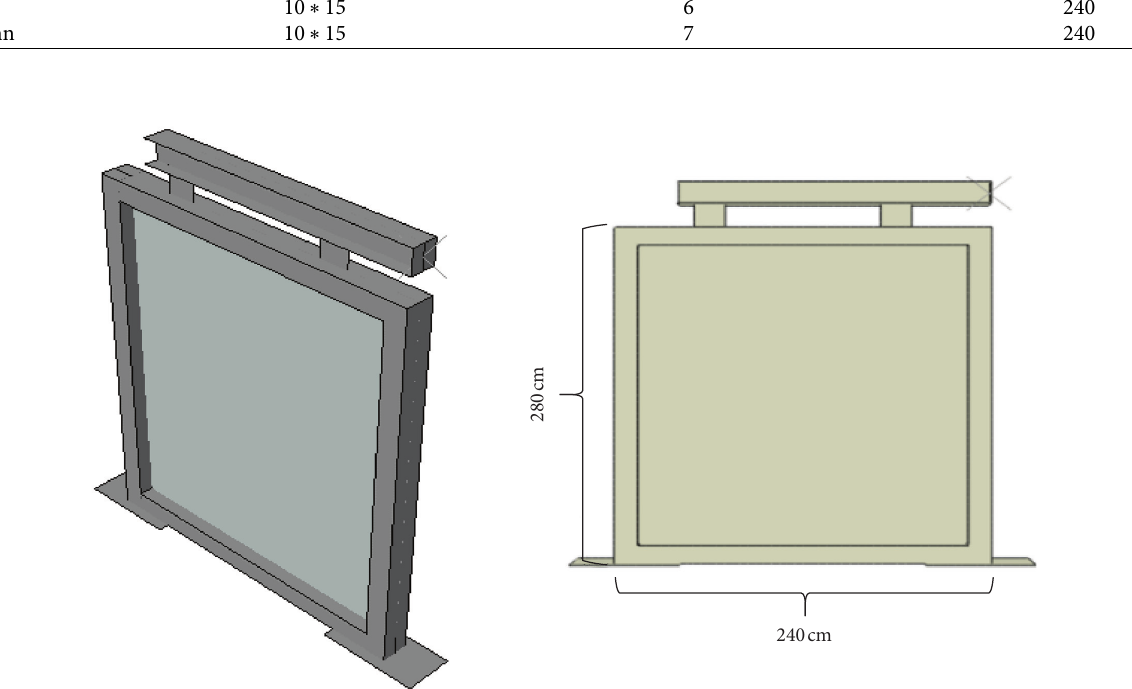
Figure 7: General dimensions of steel shear wall